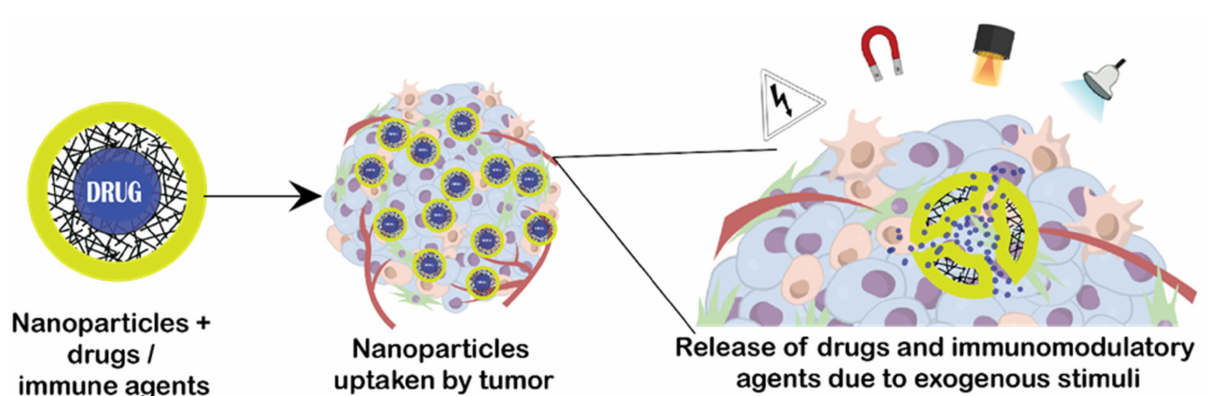
Figure 2. Different exogenous stimuli and their effects to release drugs or immunomodulatory agents in the